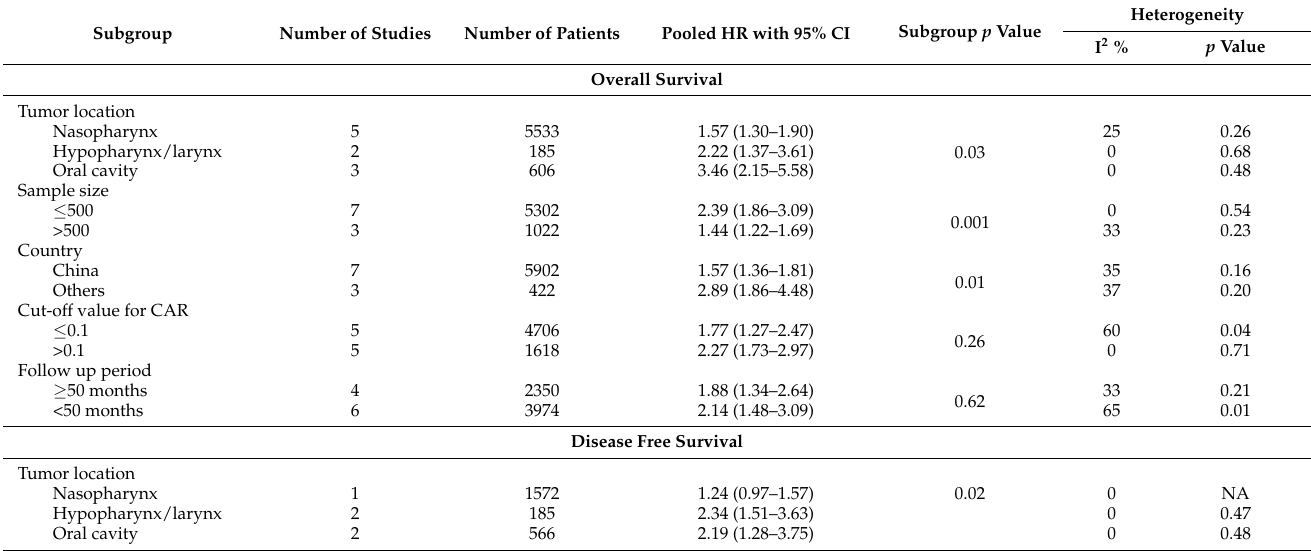
Table 2. Subgroup